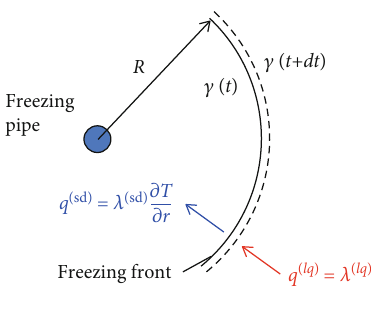
Figure 8: Heat balance at the freezing